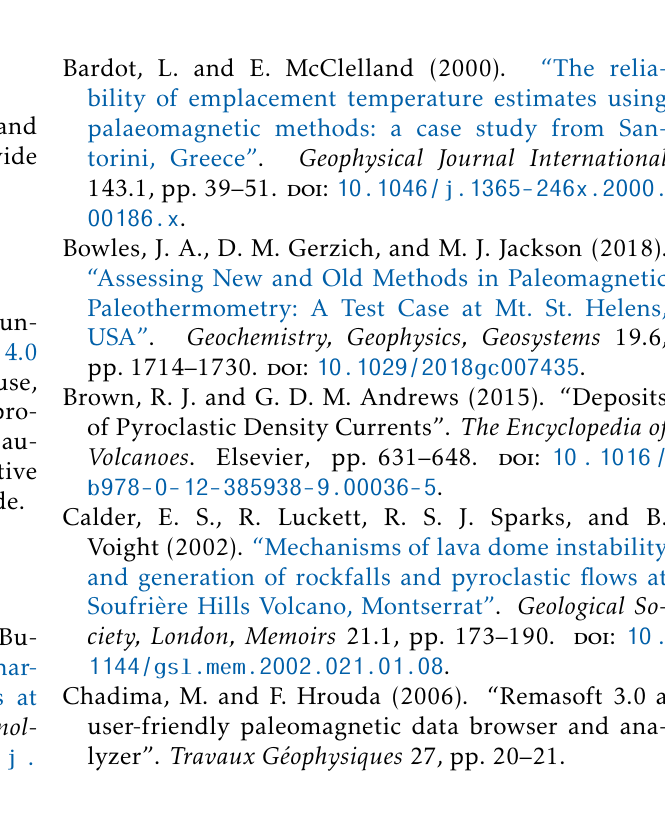
Figure 6: Equal angle projections showing directions of characteristic remanence for samples from Maero units. Open circles represent projections on the upper hemisphere, closed circles represent projections on the lower hemisphere. Open/closed triangles represent specimens classified as outliers according to Fisher statistics. Red circle = estimated site mean direction. Red dashed ring around site mean = 95 % confidence range. D = declina- tion, I = inclination, α 95 = semi-angle cone of 95 % confidence in mean direction, n/N = the ratio of the number of specimens used for the site analysis to the total number of specimens demagnetised, R = length of sum of unit vectors, k = estimate of the precision parameter [Fisher 1953]. Sites that fail a statistical randomness test [Watson 1956] show a preferred inter-clast alignment of remanence directions, interpreted to reflect post-emplacement